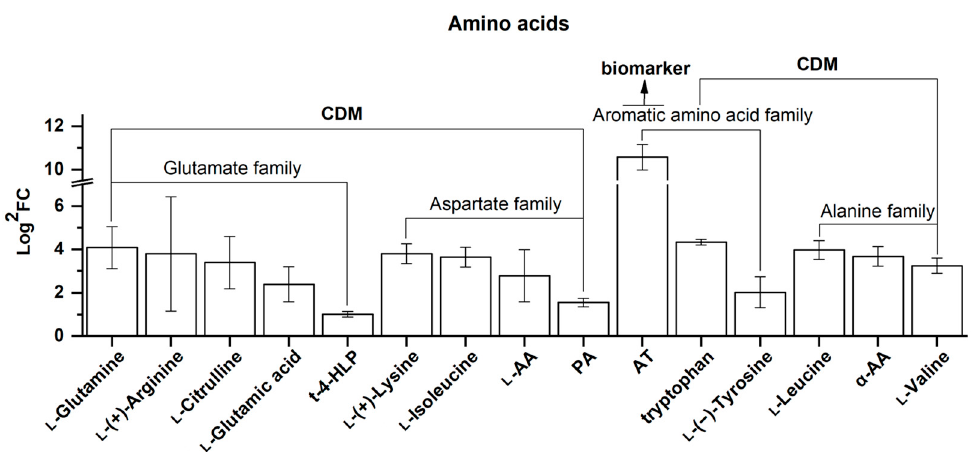
Figure 12. Comparison of amino acids, consisting of 1 biomarker and 14 CDMs between SJL and SN. They are clustered into four families, namely the glutamate family, aspartate family, aromatic amino acid family, and alanine family. Upregulation denotes that the content of a metabolite increased in SN compared with that in SJL. The Y -axis is exhibited as Log 2 FC values for the convenience of visual presentation (note that the amplitude in the text refers to the FC value). The X -axis denotes the metabolite names. Abbreviation: t -4-HLP, trans -4-hydroxy- l -proline; l -AA, l -asparagine anhydrous; PA, pipecolic acid; AT, acetyl tryptophan; α -AA, alpha-aminocaproic acid.